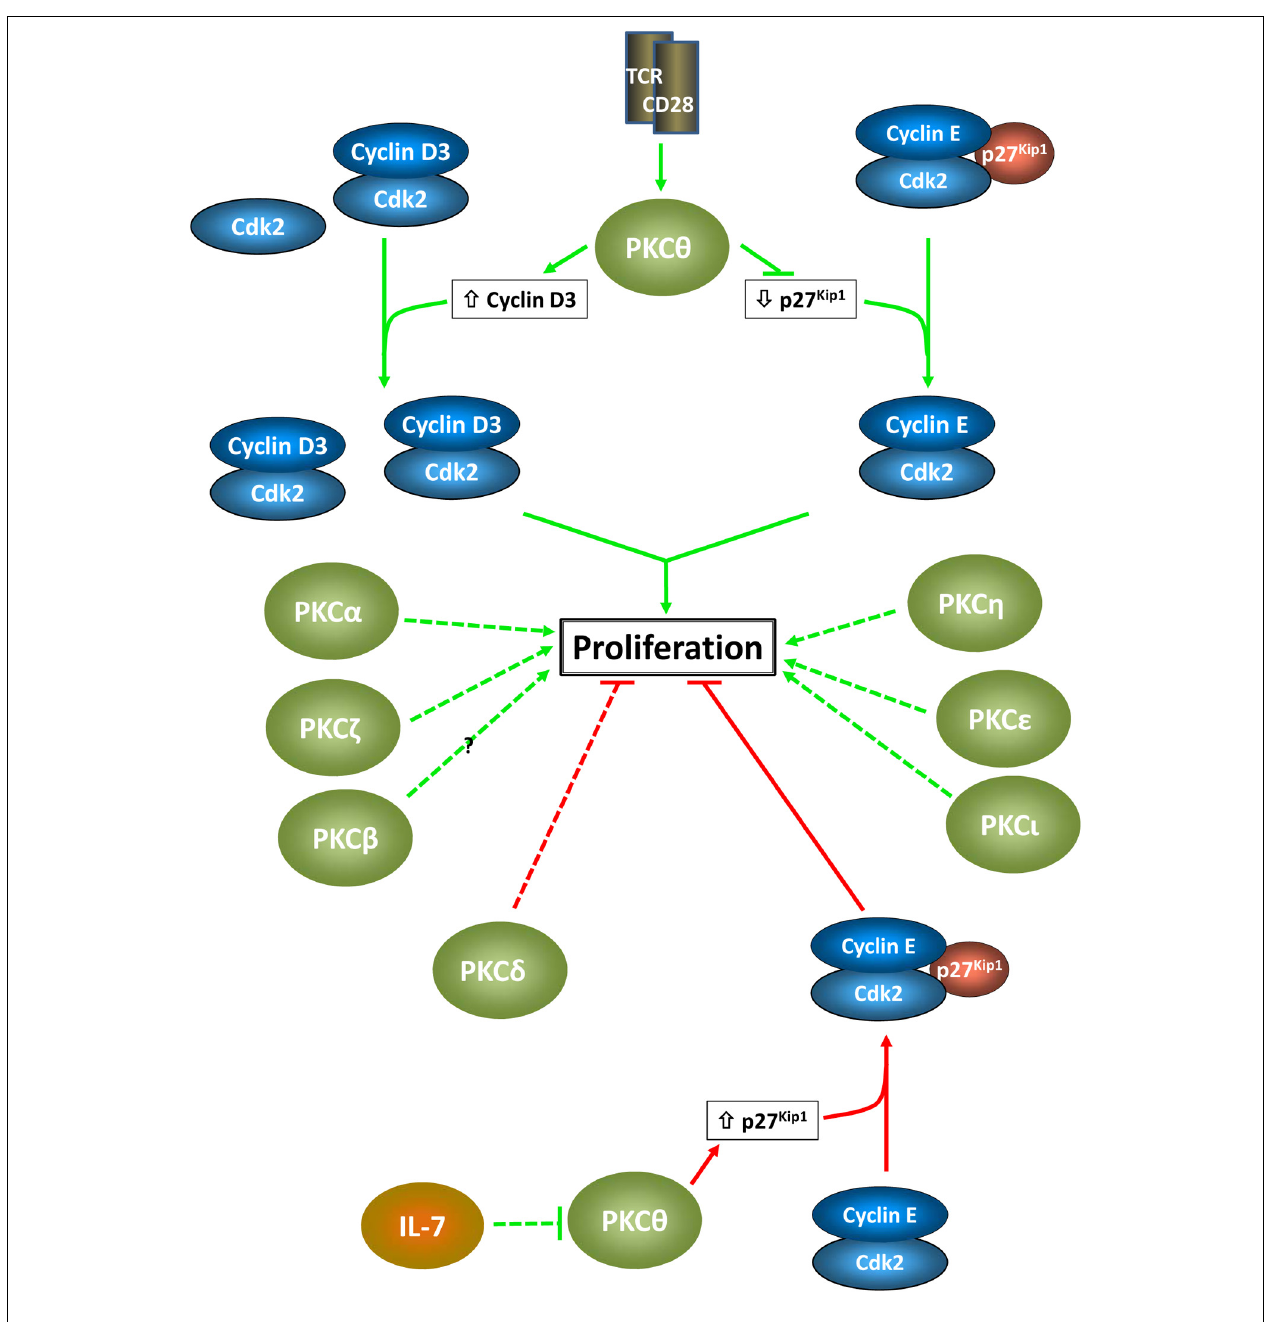
FIGURE 2 | Proliferative effects of PKC isozymes inT cells. Positive and negative proliferative effects of individual PKC isozymes are indicated by green arrows and red barred lines, respectively. Proposed cell cycle targets in the growth-inhibitory and growth-stimulatory effects of PKC θ are shown.